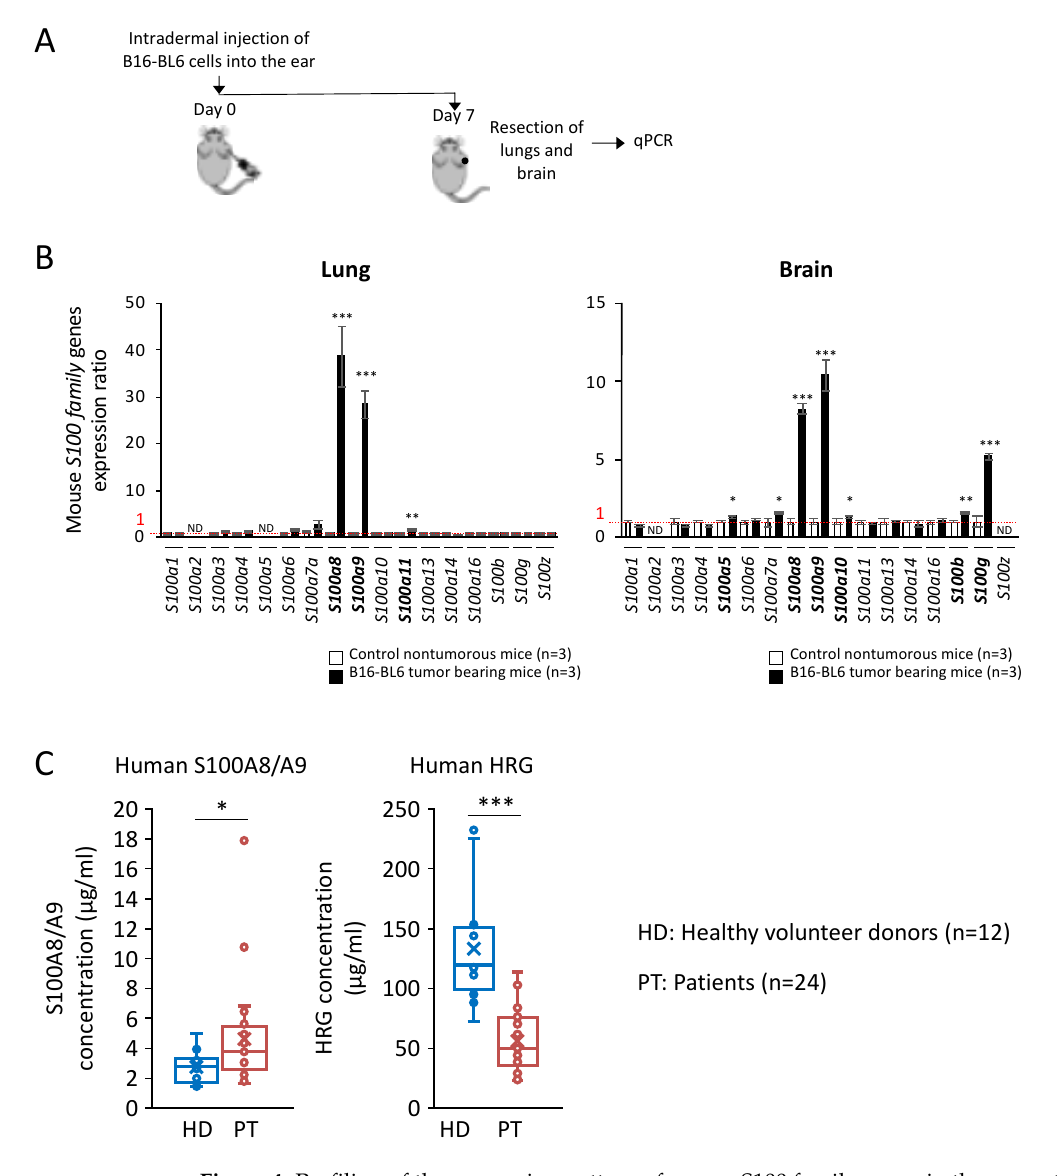
Figure 4. Profiling of the expression pattern of mouse S100 family genes in the premetastatic stage in the lungs and brain of C57BL/6J mice burdened with melanoma (B16-BL6 cells). ( A ) Lungs and brain were resected from C57BL/6J mice burdened with melanoma (B16-BL6 cells) on day 7 after inoculation of melanoma to the subcutaneous area of the ear. ( B ) Total RNAs prepared from the indicated organs (lungs and brain) were analyzed for the expression of S100 family genes by quantitative real-time PCR. Tbp mRNA was used as a control for the analysis. The data were expressed as an expression ratio in comparison with the respective values from the healthy lungs and brain of nontumorous control mice, which were set as 1. ( C ) S100A8/A9 and HRG levels in the plasma collected from brain-metastatic lung cancer patients. The backgrounds of patients are described in Materials and Methods. S100A8/A9 and HRG levels were measured with ELISA. Data in panels ( B , C ) are means ± SD. * p < 0.05, ** p < 0.01, and *** p < 0.001 by Student’s t